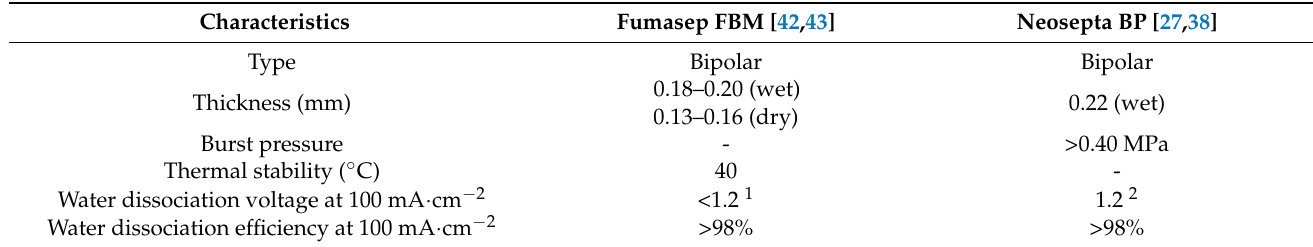
Table 2. Bipolar membranes’ technical